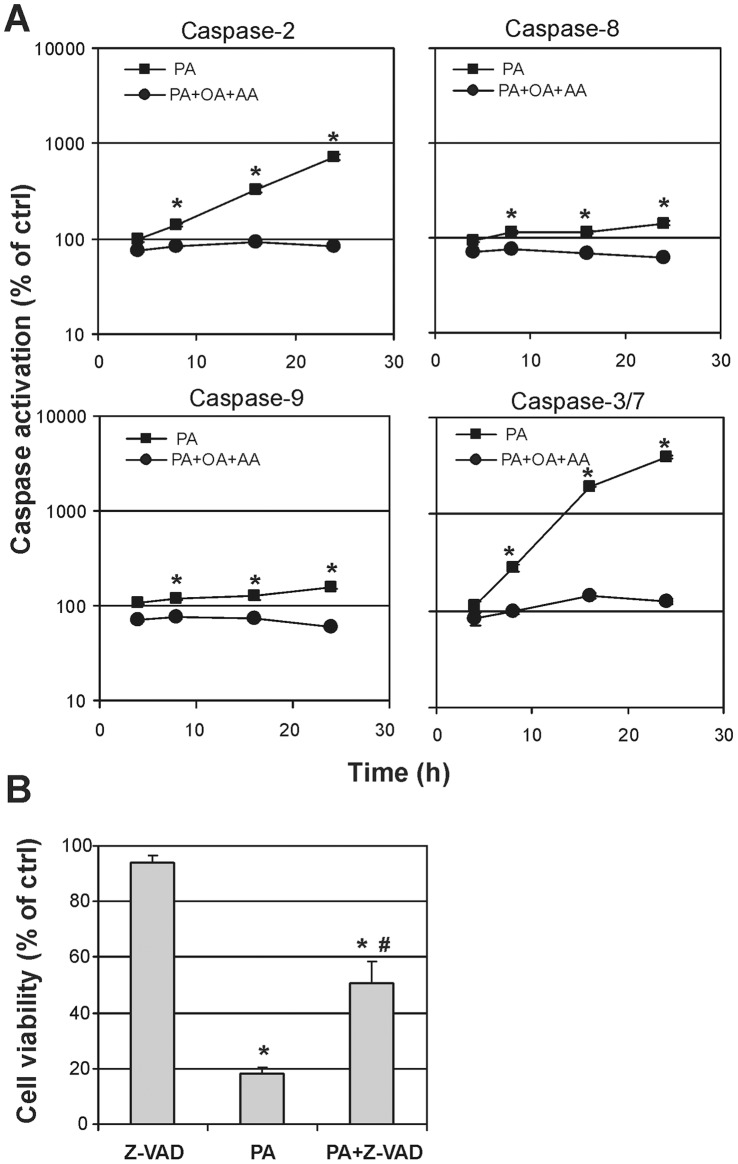
Evaluation of apoptosis in NB100 cells supplemented with fatty acids.(A) Caspase activation in NB100 cells exposed to PA 150 µM (▪) or PA 150 µM+OA 50 µM+AA 50 µM (•). Caspase-2, -8, -9 and -3/7 activation was determined at 3, 8, 16, 24 hours as described in Materials and Methods. Caspase activity is expressed as percentage of control values obtained form cultures grown in the absence of FA supplementation. Mean results ± SD are reported. (B) Cell viability was evaluated at 24 hours on NB100 cells pretreated with 30 µM of the irreversible tetrapeptide pan-caspase inhibitor Z-VAD-fmk, added to the culture 3 hours before the 150 µM PA supplementation.